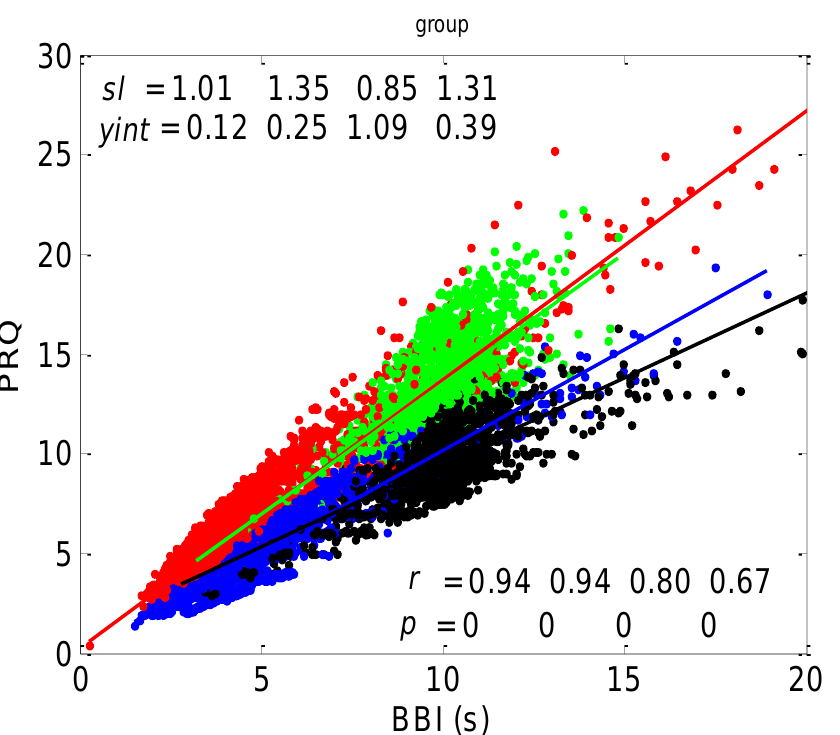
Figure 6. Diagram showing the group scatter plot of correlations between BBI and PRQ , where the results from twenty subjects in four states were superimposed. Each dot represents the result for one BB interval. The group linear regression for each state is drawn as a solid line: blue — supine; red — standing; black — supine, with slow 0.1 Hz breathing; green — standing, with slow 0.1 Hz breathing. Linear regression slopes ( sl ) with Y-intercepts ( yint ). Pearson’s coefficients of linear correlation ( r ) and regression significance ( p , showing very high significance) are indicated as well, ordered from left to right as: supin, stand, supin01, and